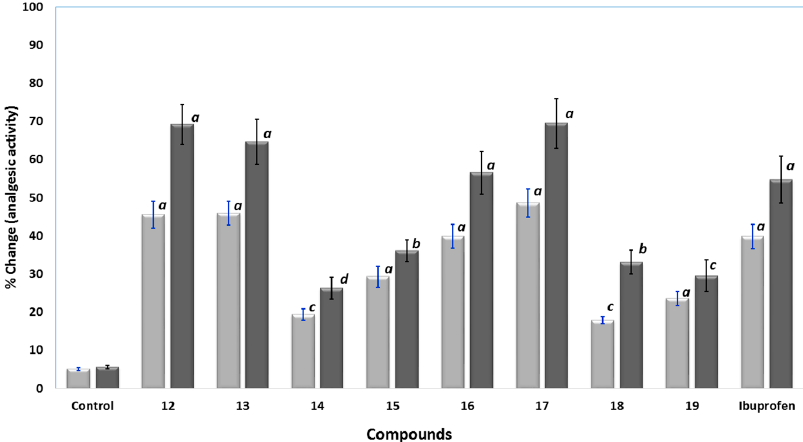
Figure 6. The analgesic activity results using hot-plate test for control, compound 12 – 19 , and ibuprofen at 0.24 ( ▄ ) and 0.48 mmol/kg ( ▄ ); data were represented as means ± SEM, n = 6; data were analyzed by One way ANOVA followed by student-Newman-Keuls multiple comparison test; % change = 100 × (T 1 ´ T 0 )/T 0 ; a statistically significant from control ( p < 0.001); b statistically significant from control ( p < 0.01); c statistically significant from control ( p < 0.05); d statistically not significant from